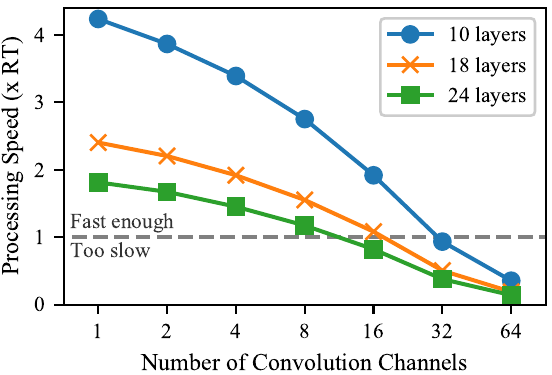
Figure 4. The processing speeds of models with different numbers of layers and convolution channels. The models use the gated activation. The cases above the horizontal dashed line can run in real time.